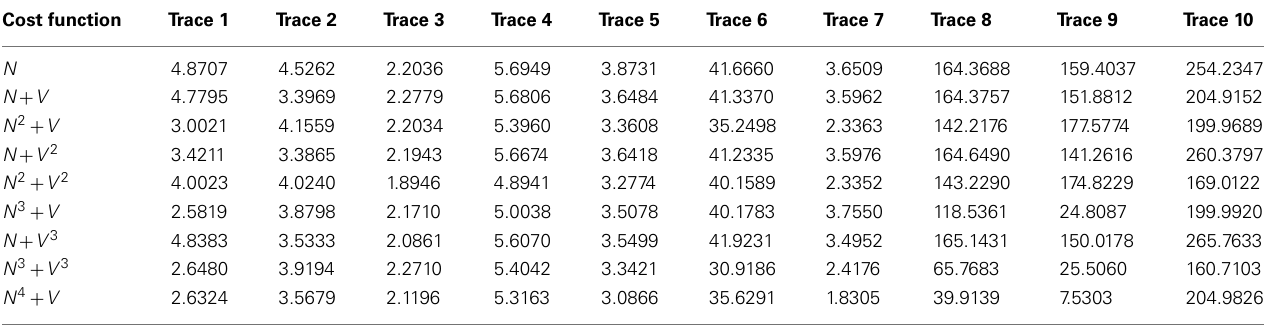
Table 5 |The mean square x/y tracking error for each of the ten benchmark problems over all nine cost functions. Cost function